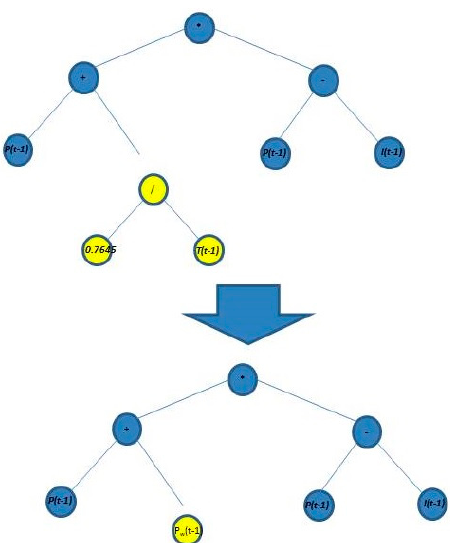
Figure 6. Mutation process in the GP to forecast the scale parameter.